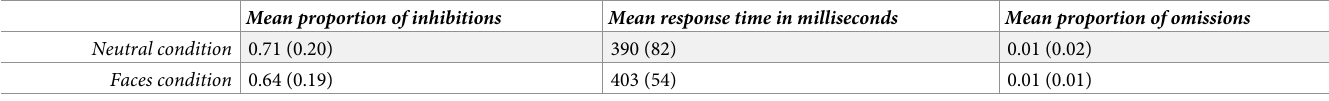
Table 1. GNG task performance data (N = 50).